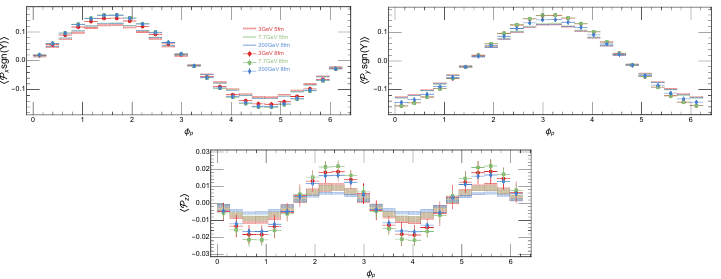
Figure 3. The dependence of hyperon local polarization components on the azimuthal angle φ p for col- lisions with impact parameter b = 5 , 8 fm and with beam energy √ s NN = 3 , 7 . 7 , 200 GeV, respectively. The bands (for b = 5fm) or error bars (for b = 8fm) represent statistical uncertainty from y Λ < 1 . 0 and Figure 1. Λ global polarization signal as a function of collision beam energy with | | 0 . 4 GeV < p T < 3 . 0 GeV, for AuAu collisions at impact parameters b = 5 fm (red), 7 fm (green) and 8 fm (blue), with the bands representing statistical uncertainty from our simulation. Relevant measurements are also shown, with the STAR data from Ref.[1] and the HADES data from Ref. [20].